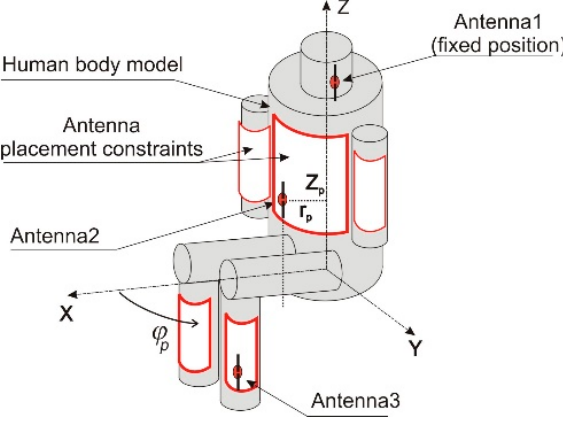
Figure 1. The wireless body area sensor network on the simplified cylindrical human body model.